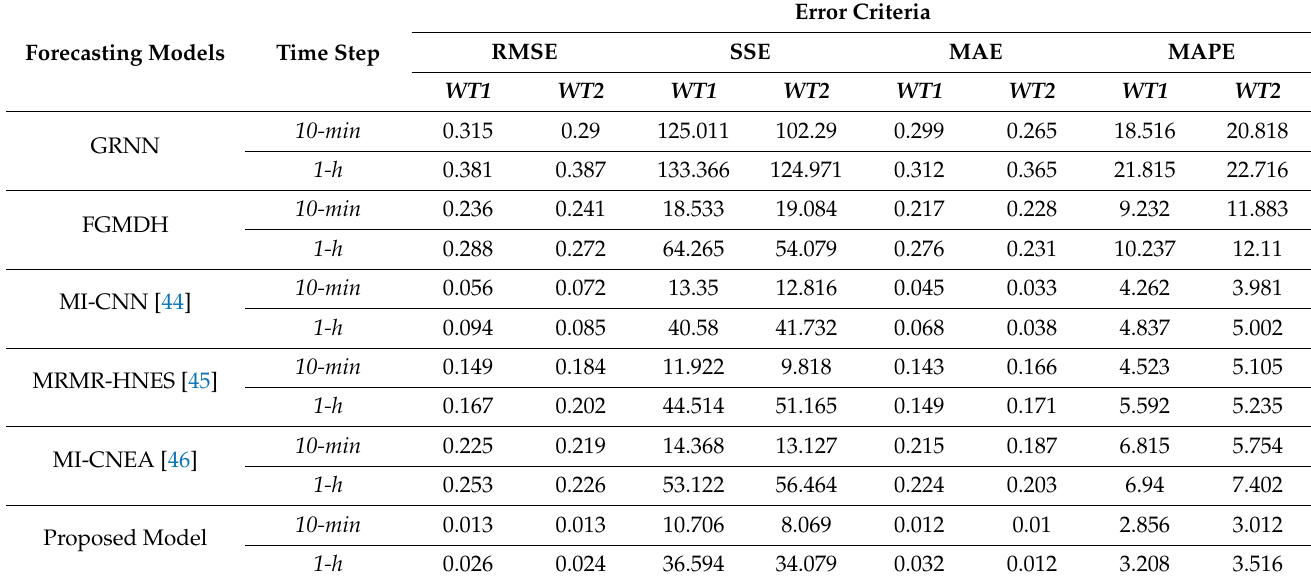
Table 1. Comparison of the wind turbine power forecasting errors of the models for two wind turbines (WT1 and WT2).